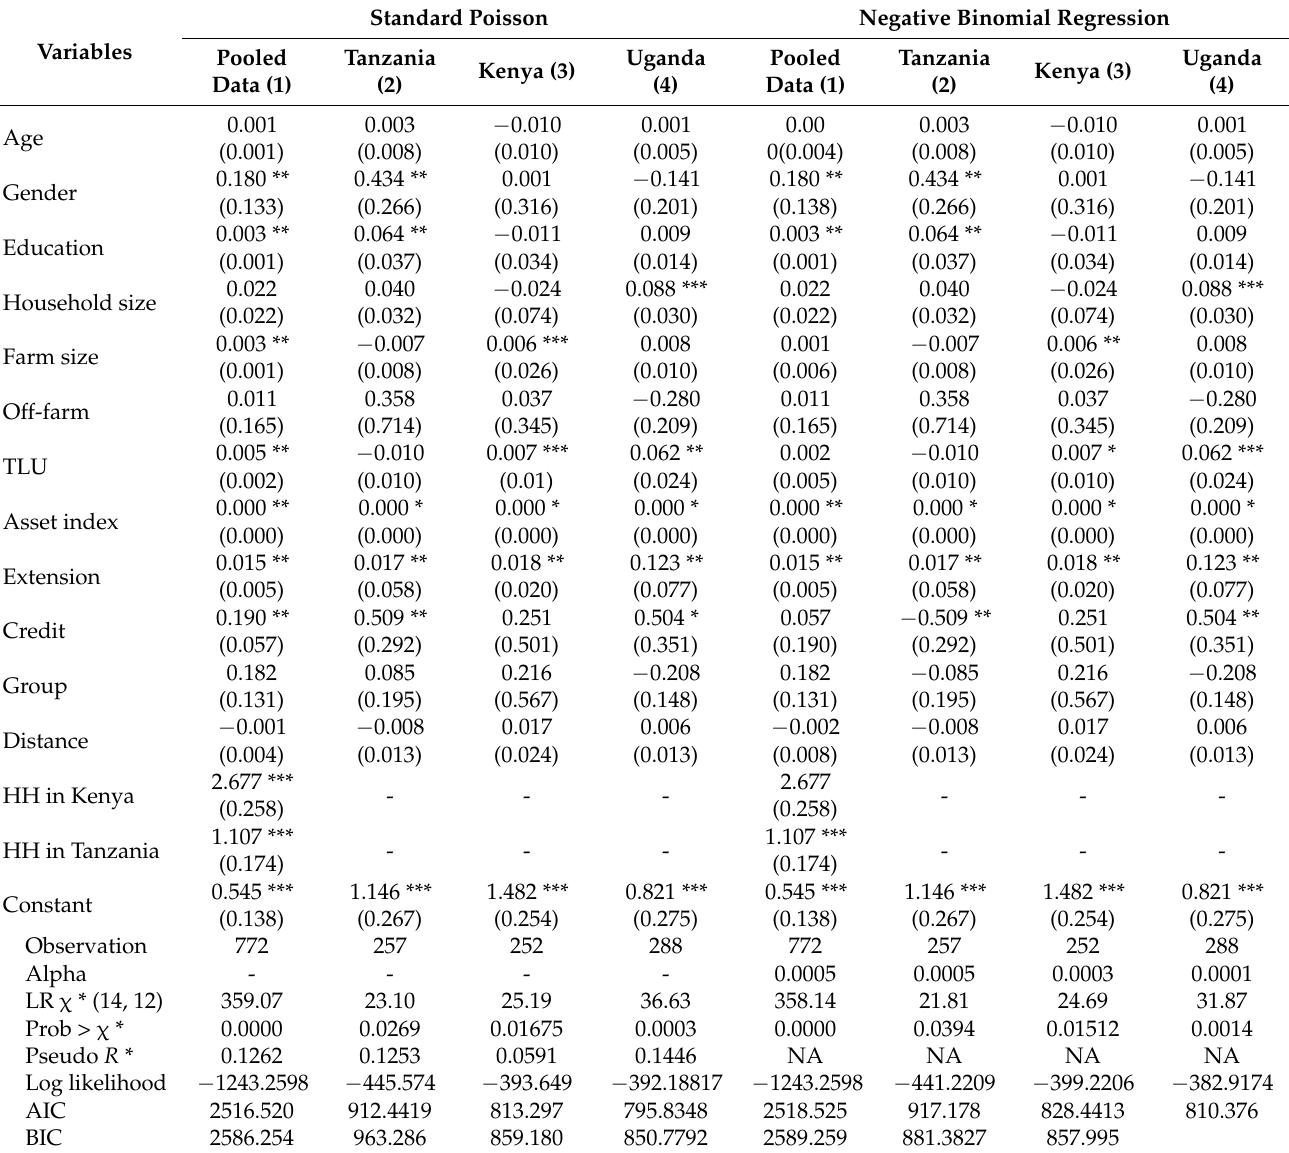
Table 6. Marginal effects for the Poisson and negative binomial regression